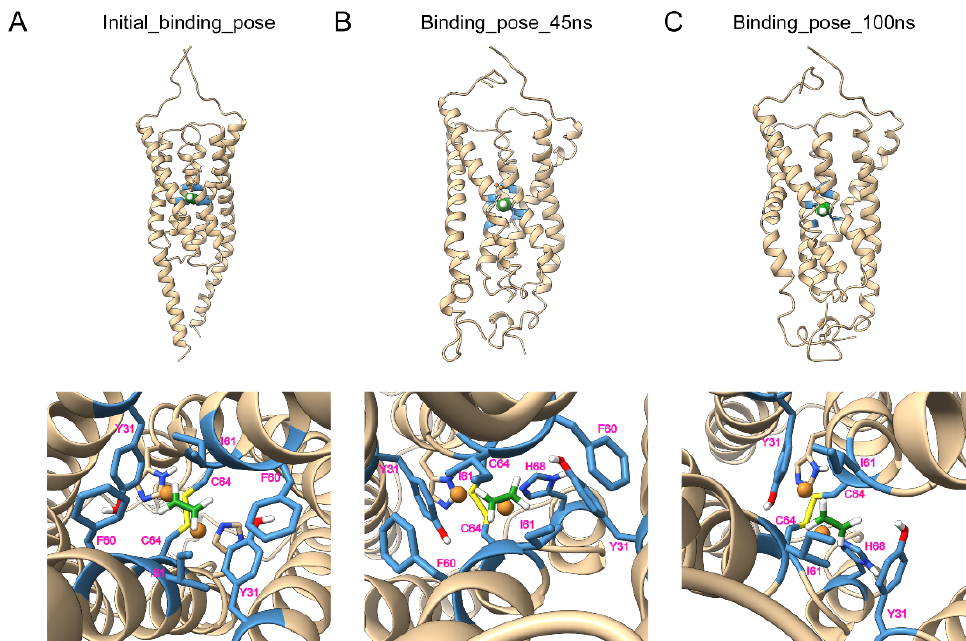
Figure 4. The molecular dynamics simulation of LeETR2 1–131 -C 2 H 4 . ( A ) The initial docking model of LeETR2 1–131 -C 2 H 4 in the presence of Cu + using molecular docking. The initial binding region was set around the copper binding sites C64 and H68 of LeETR2 1–131 . The calculated binding sites were Y31, F60, I61, and C64. ( B ) The molecular dynamics simulation of LeETR2 1–131 -C 2 H 4 in the presence of Cu + at a time of 45 ns; the MD trajectory was typically stable, and the binding sites were still stabilized at the sites of Y31, F60, I61, C64, and H68. ( C ) The molecular dynamics simulation of LeETR2 1–131 - C 2 H 4 in the presence of Cu + at a time of 100 ns. The snapshot shows that the binding conformation did not change very much; the interaction sites were located at Y31, I61, C64, and H68. The Cu + ions are shown as spheres in bronze. The ethylene (green) or hydrogens (white) are shown as spheres or sticks. The chains of LeETR2 1–131 are in gold, and the binding sites are colored in steel blue.